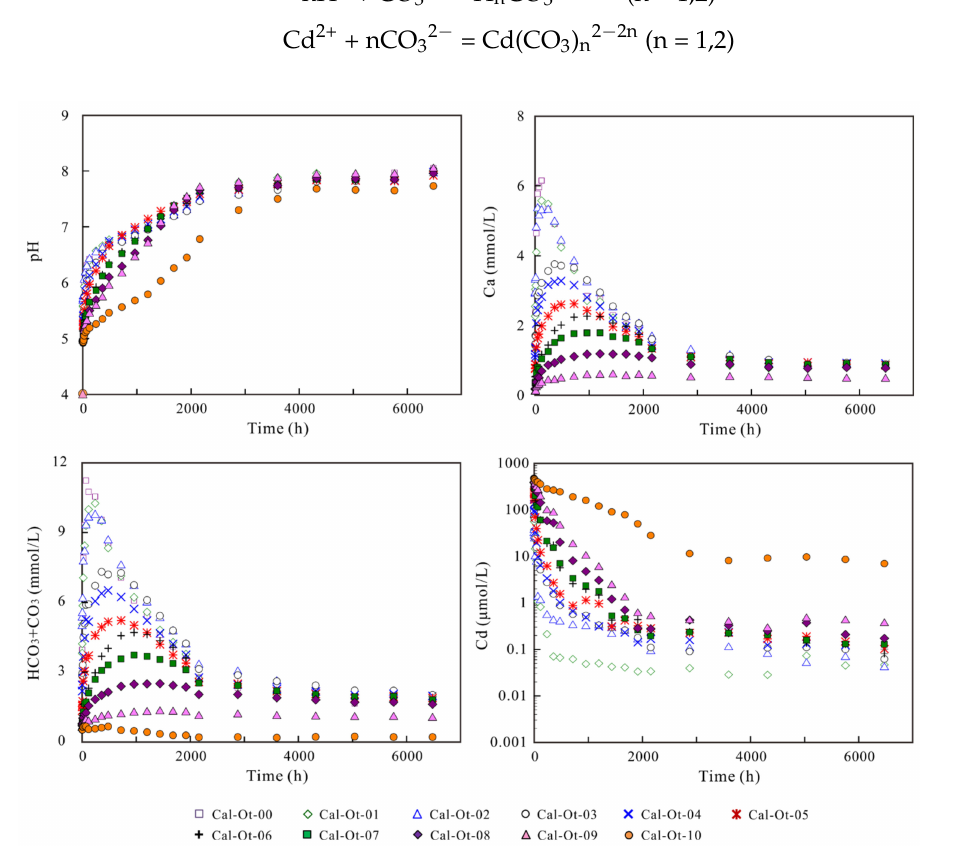
Figure 6. Change of the aqueous pH, the total dissolved calcium, the total dissolved cadmium and the total dissolved H 2 CO 30 during the dissolution of the (Ca 1 − x Cd x )CO 3 solid solutions in the CO 2 -saturated